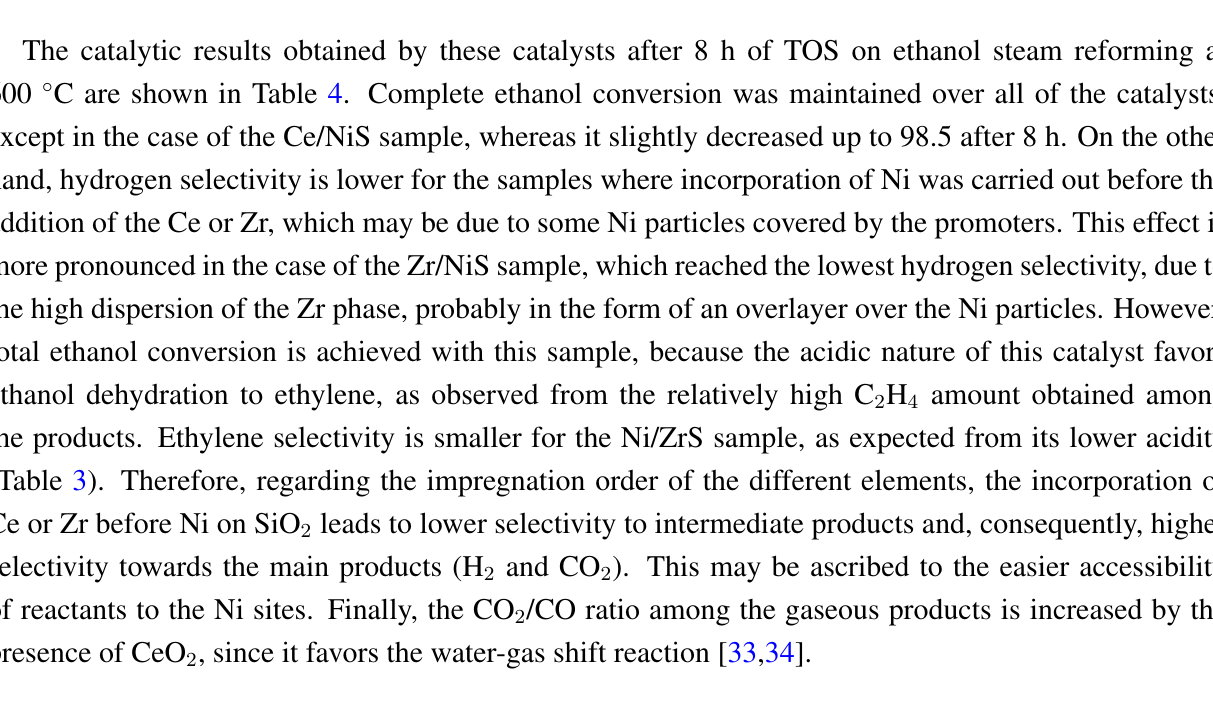
catalyst modified by 2